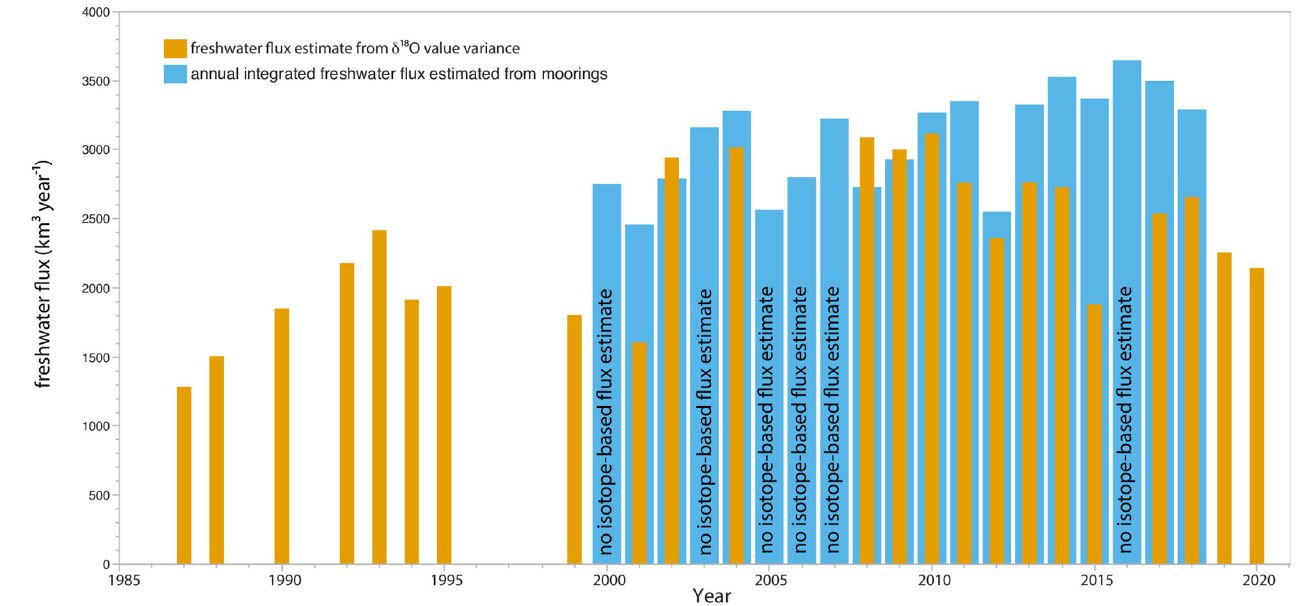
Fig 6. Estimated freshwater flux through Bering Strait using oxygen isotope variation versus mooring estimates (data from [2]).